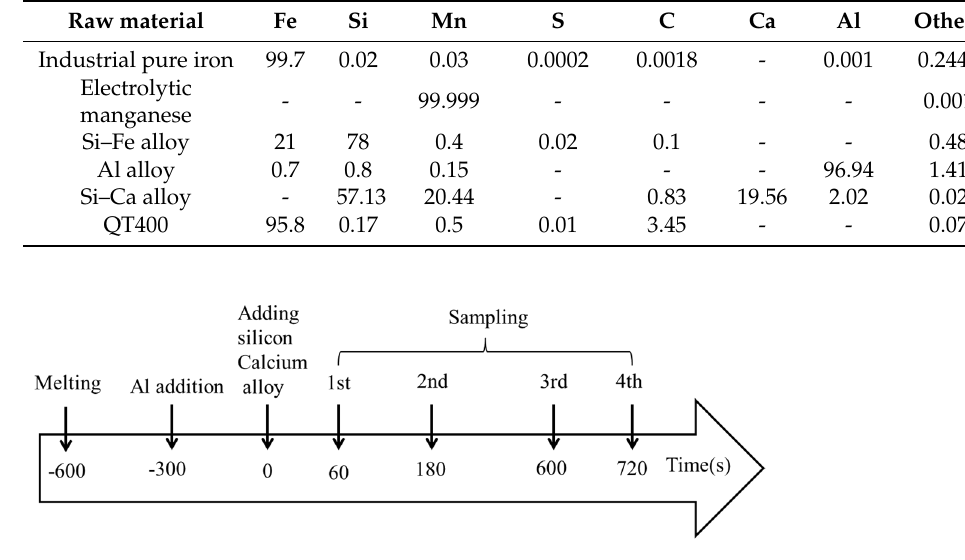
Figure 2. Addition of alloys and sampling procedure used in current experiments.